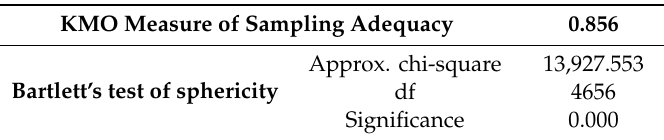
Table 10. Kaiser-Meyer-Olkin (KMO) measure and Bartlett’s test.